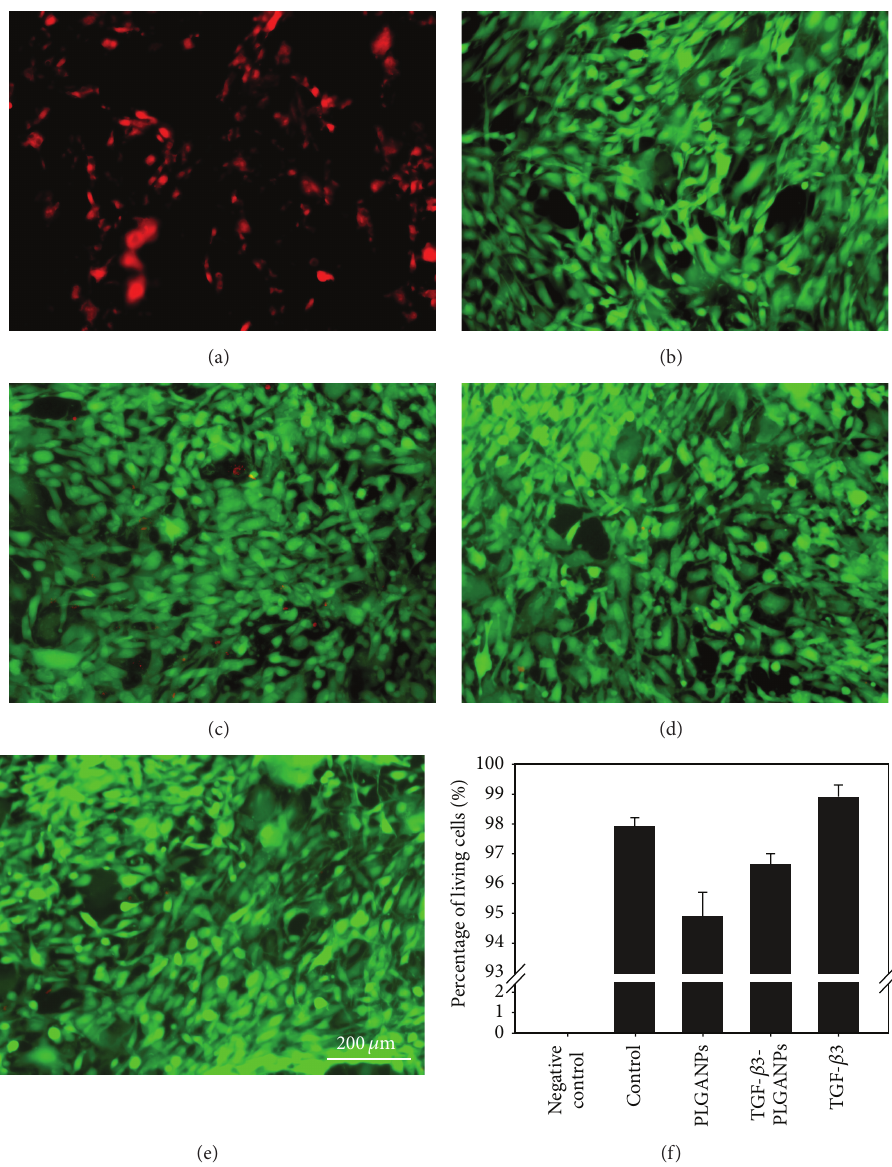
Figure 4: Cytotoxicity assay of the MSCs cocultured with (a) 0.1% Triton-X (negative control), complete culture medium containing; (b) no supplement (control); (c) 1000 𝜇 g/mL blank PLGANPs (PLGANPs); (d) 1000 𝜇 g/mL TGF- 𝛽 3-loaded PLGANPs (TGF- 𝛽 3-PLGANPs);